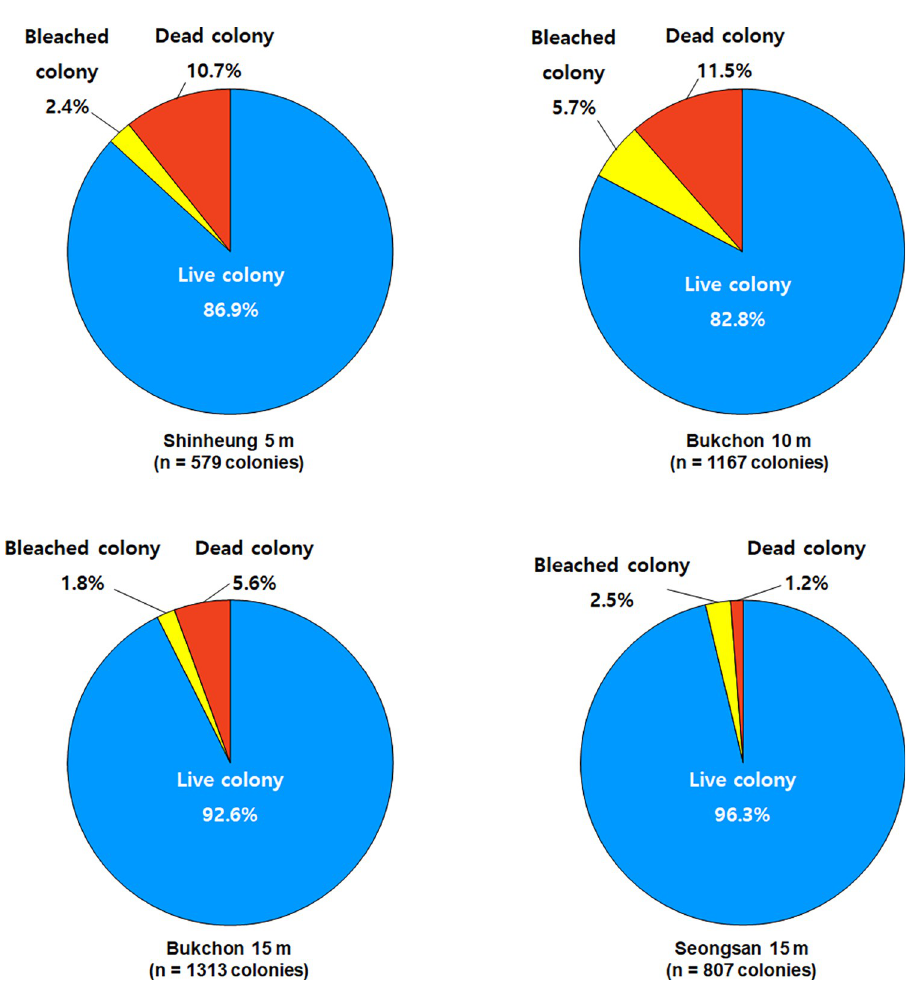
Fig 6. The prevalence (%) of different conditions (live, bleached, and dead colony) of A . japonica colonies observed on 20-m line transects installed at depths of 3 survey sites SH, BC, SS. The total number (n) of colonies (live + bleached + dead) analysed at each site is shown below the site name of each pie chart.